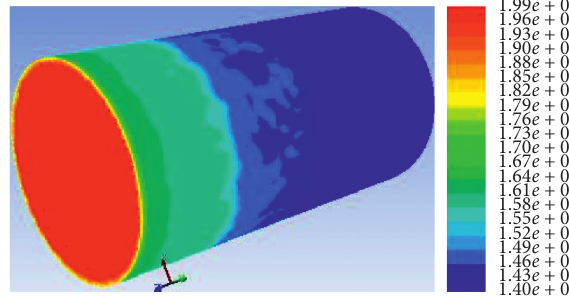
Figure 15: Temperature cloud diagram of the flame tube.